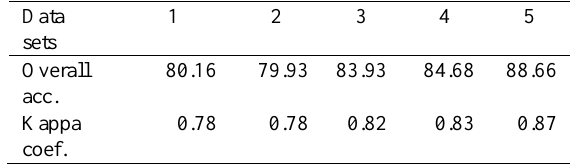
Table 3. RF classification results for Landsat 7 ETM+ and